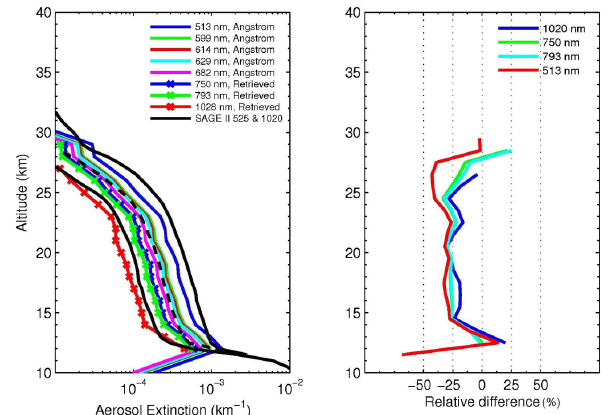
Fig. 9. Multiple iterations of retrieved aerosol extinction profiles at 793 (left) and 1028nm (right) and the a priori profile.